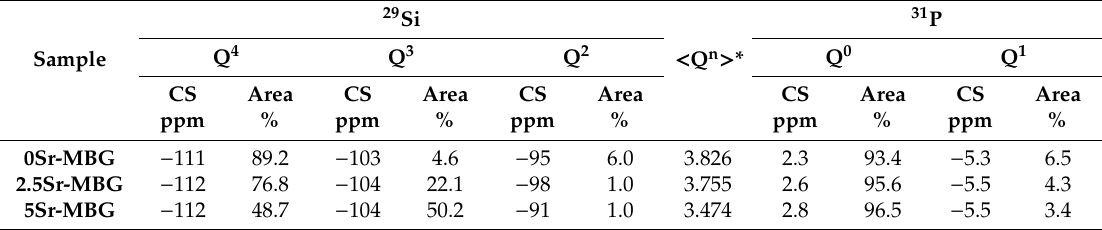
Table 3. Chemical shifts (CS) and the relative peak areas obtained by solid state 29 Si and 31 P single pulse MAS NMR spectroscopy. The peaks areas for the Q n units were calculated by Gaussian line–shape deconvolution; their relative populations were expressed as percentages